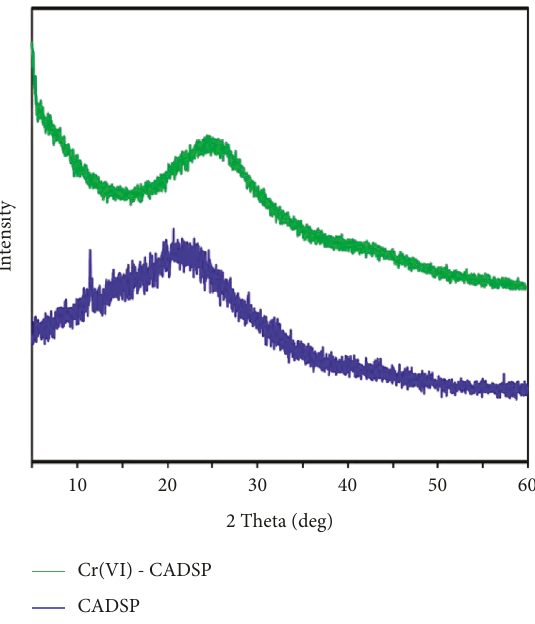
Figure 3: XRD of CADSP and Cr(VI) adsorbed